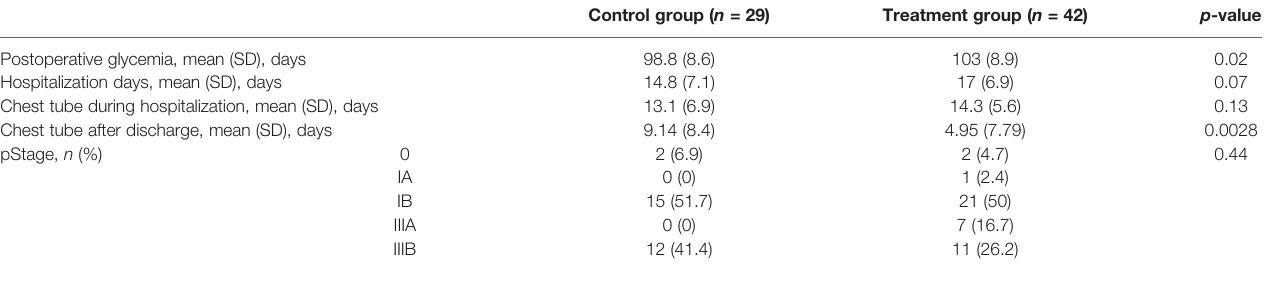
TABLE 2 | Postoperative and pathological characteristics of patients.